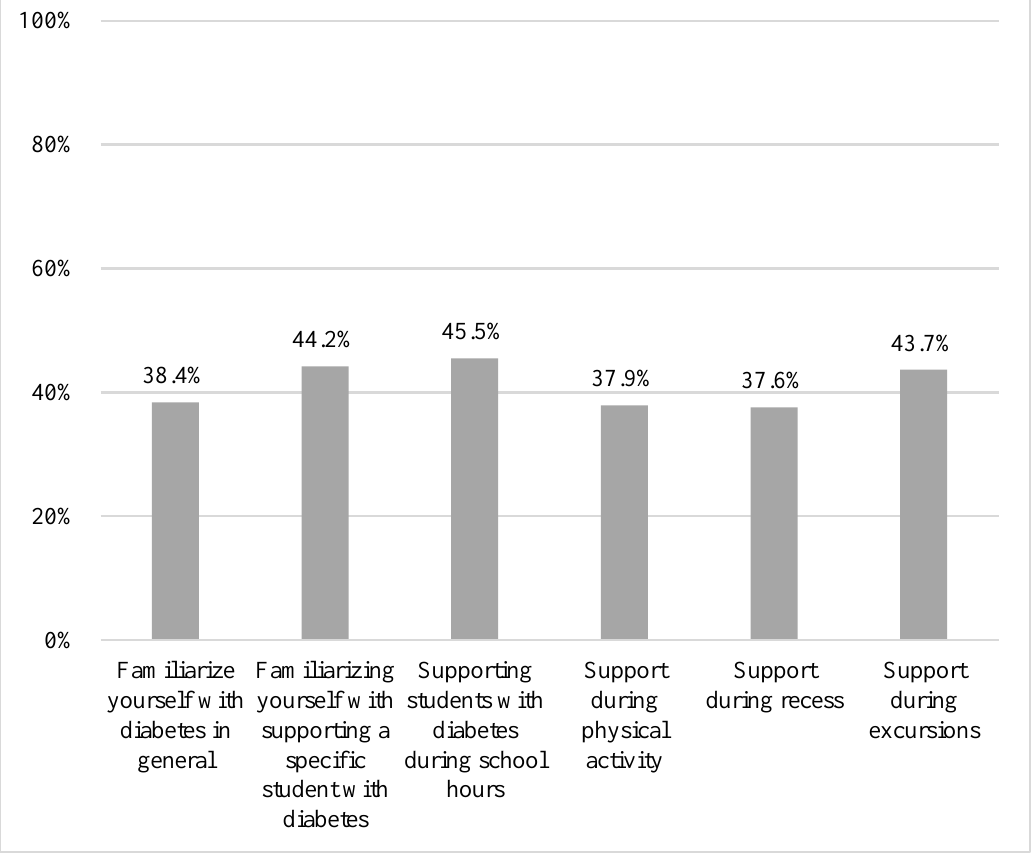
Figure 5. Proportion of participants with adequate time to support.